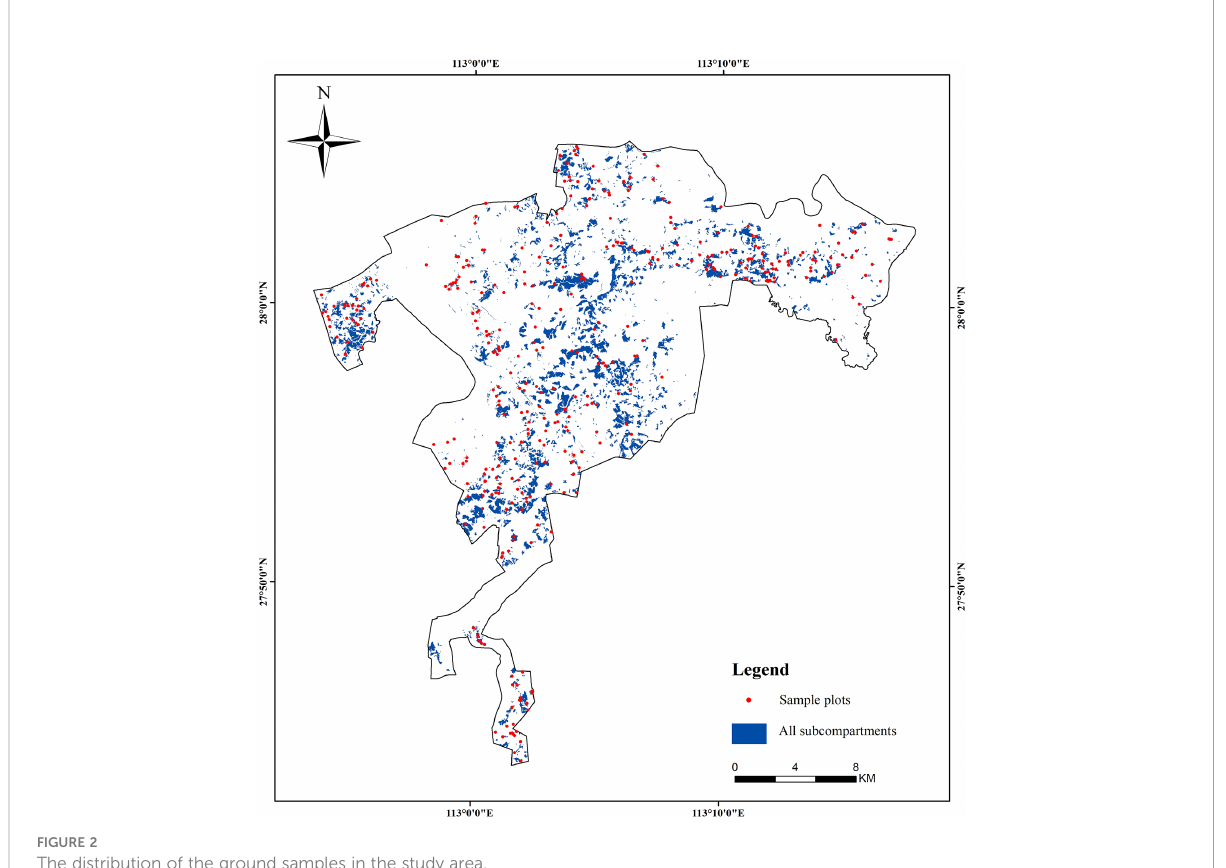
FIGURE 2 The distribution of the ground samples in the study